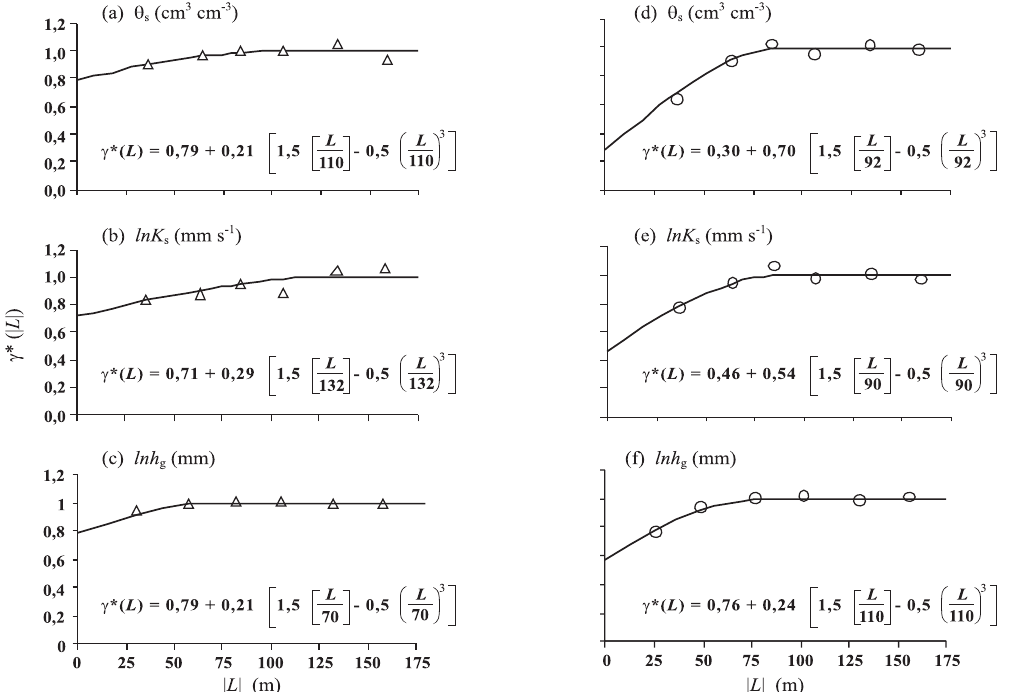
Figura 4. Semivariogramas experimentais e teóricos normalizados de θθθθθ (a), (b) e (c) e Latossolo Amarelo (d), (e) e